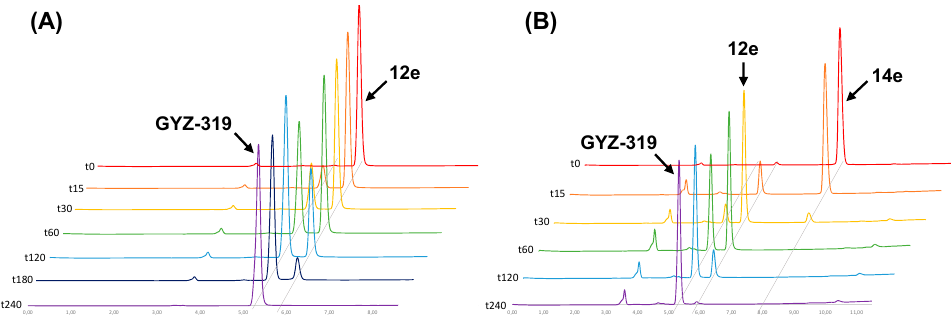
Figure 2. Esterase-mediated hydrolysis bisubstrate inhibitor prodrugs. ( A ) Hydrolysis of isopropyl